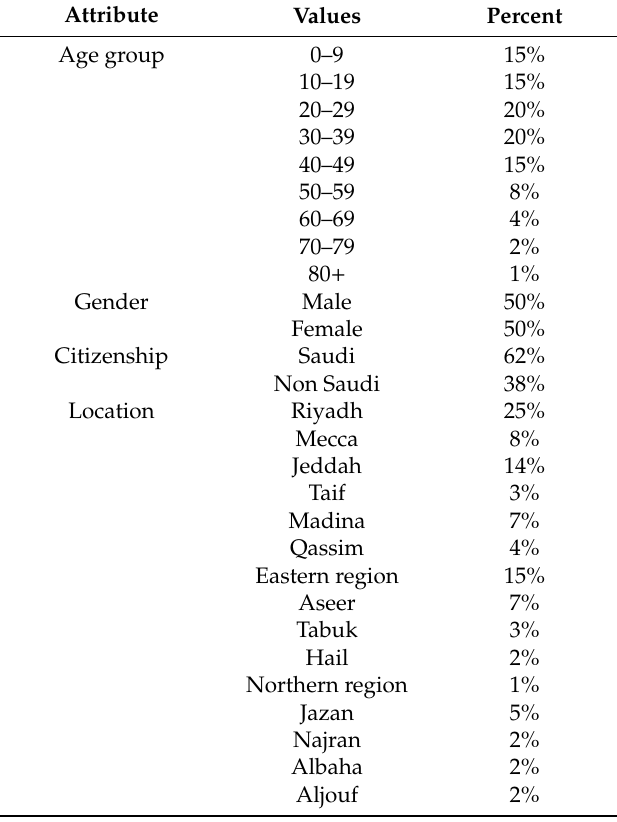
Figure A1. Distribution of nodes by age group, gender, citizenship, and location. Table A1. Distribution of nodes by age group, gender, citizenship, and location. The age distribution of individuals was based on citizenship and gender but is approximated here. Similarly, the gender distribution was also based on citizenship but is approximated here.